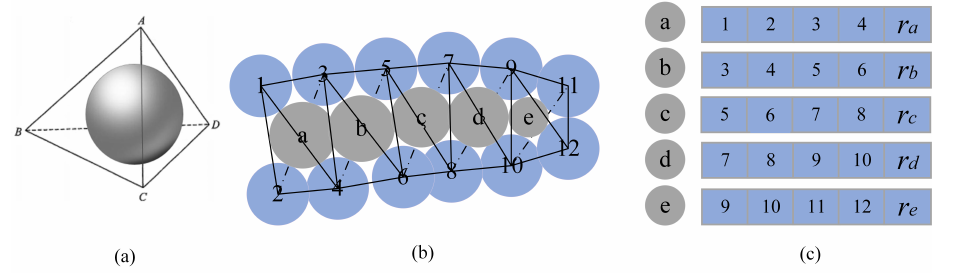
Figure 3. Protein molecular pocket representation. ( a ) Alpha sphere. ( b ) Protein molecular pocket. ( c ) Molecular pocket